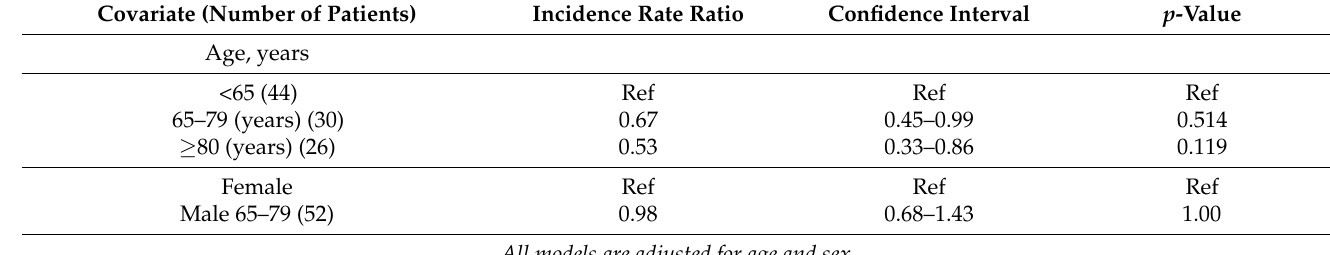
Table A2. Factors associated with prescribing discrepancies between actual use of medication compared to dispensed medication in the shared medication record